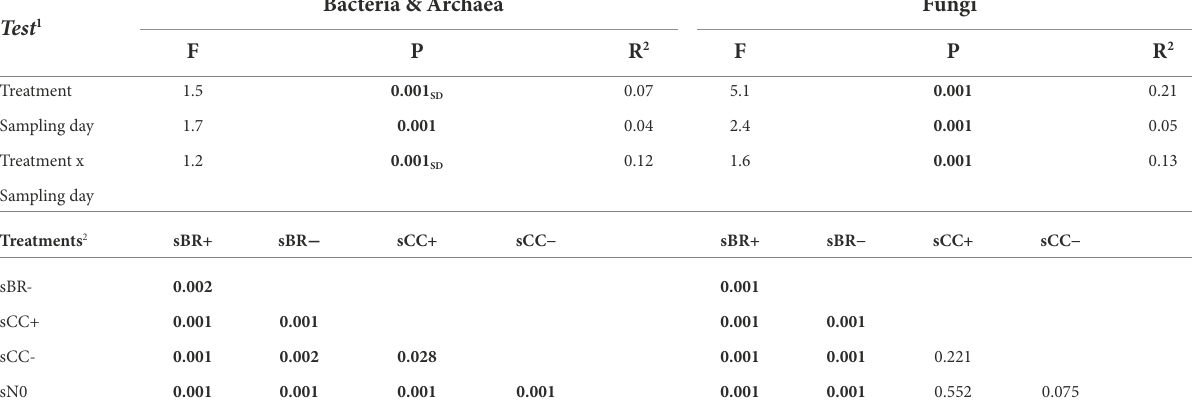
TABLE 3 Effects of fertilizer treatment on microbial beta-diversity determined by PERMANOVA. Significant values ( p < 0.05) are indicated in bold. Bacteria & Archaea Test 1